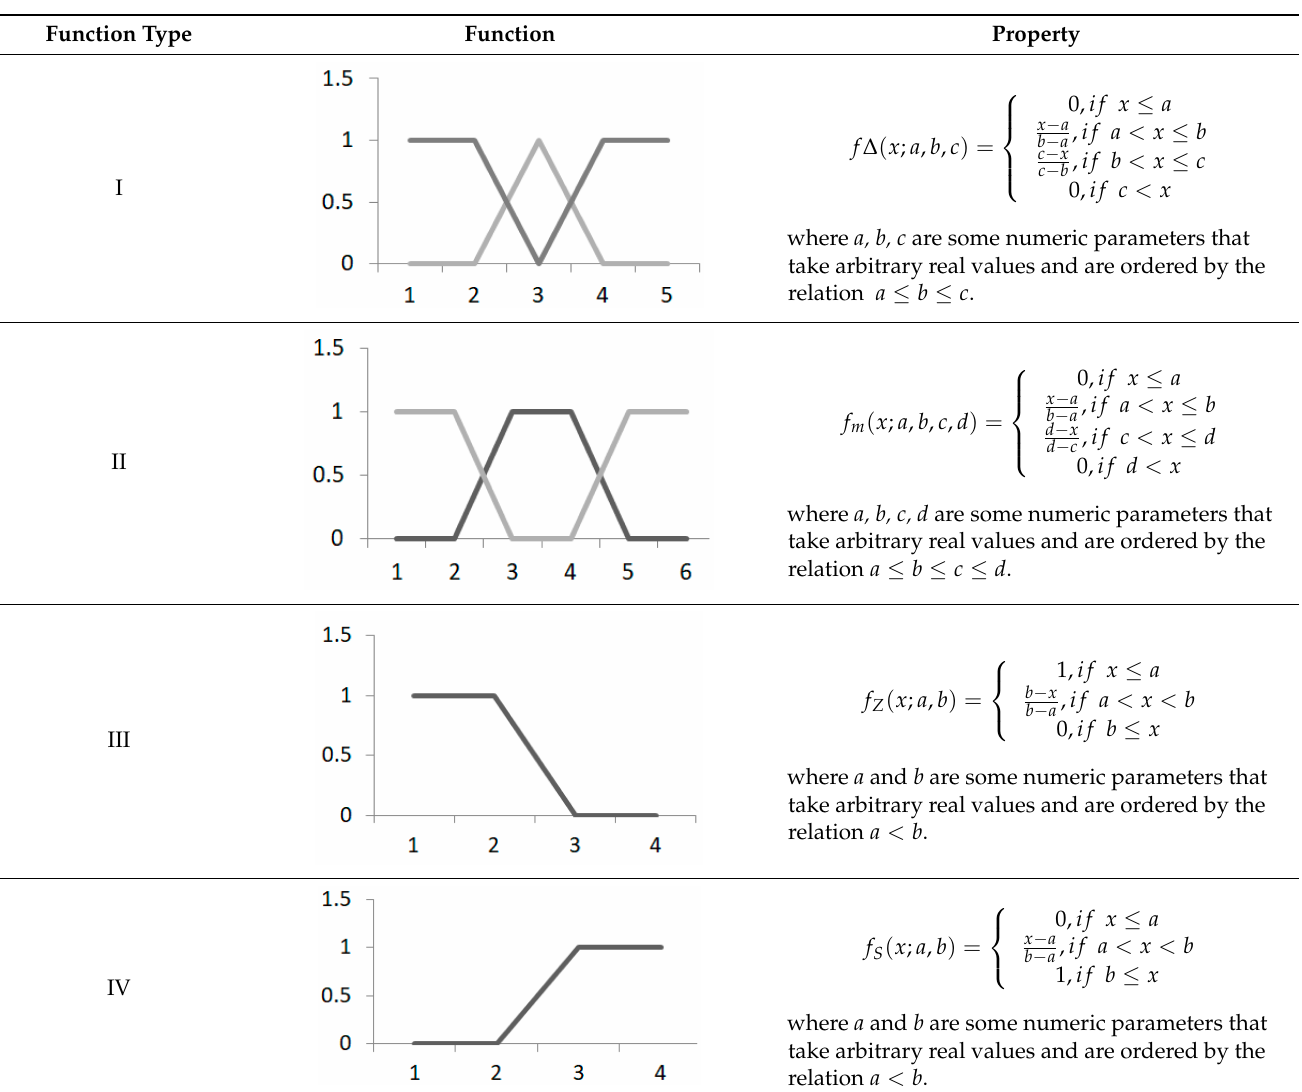
Table 1. Piecewise linear membership functions using fuzzy set